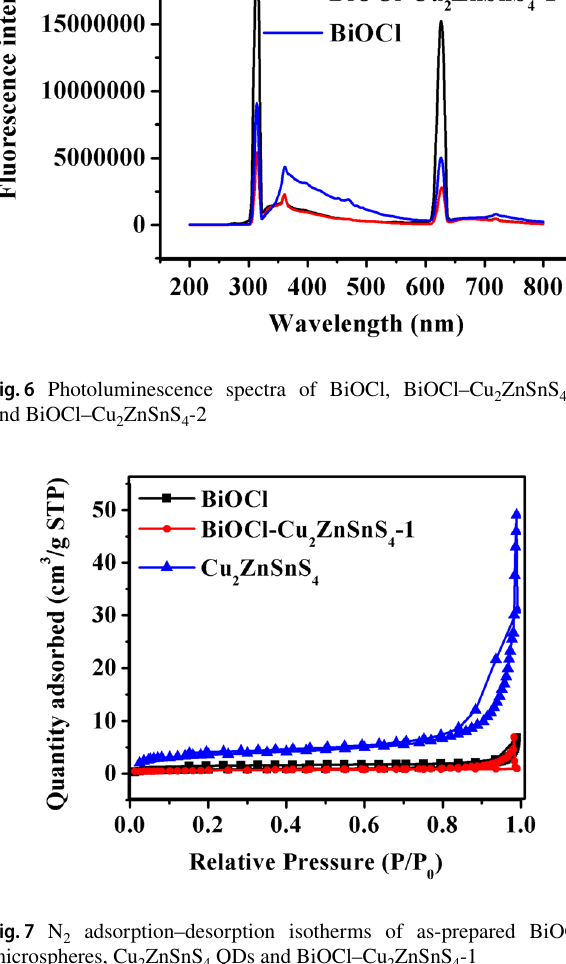
Fig. 7 N 2 adsorption–desorption isotherms of as-prepared BiOCl microspheres, Cu 2 ZnSnS 4 QDs and BiOCl–Cu 2 ZnSnS 4